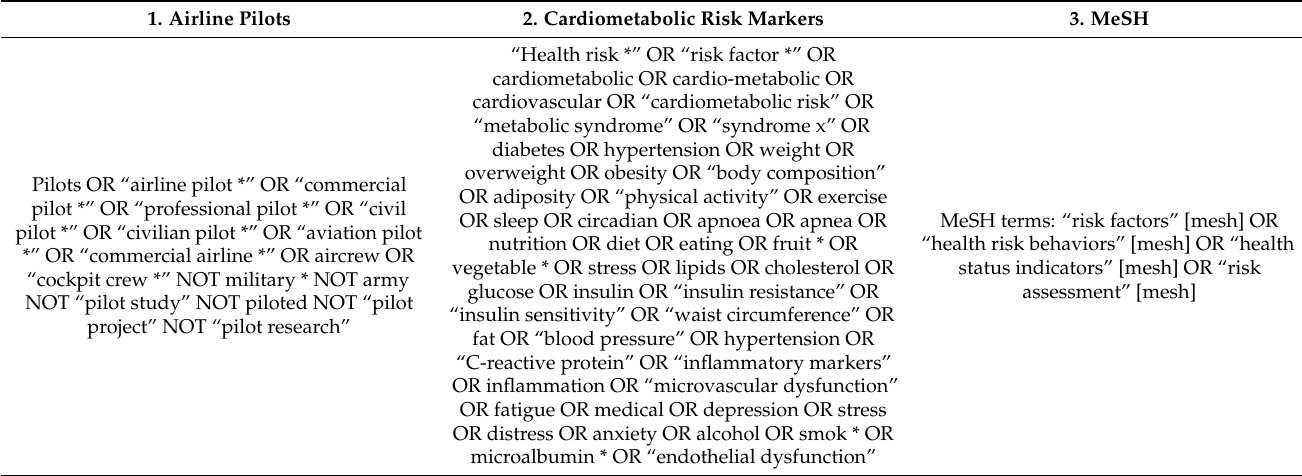
Table 1. Search terms blocks were combined for text and word search in PubMed and adapted to the remaining databases: 1 and 2; 1 and 3; 1, 2, and